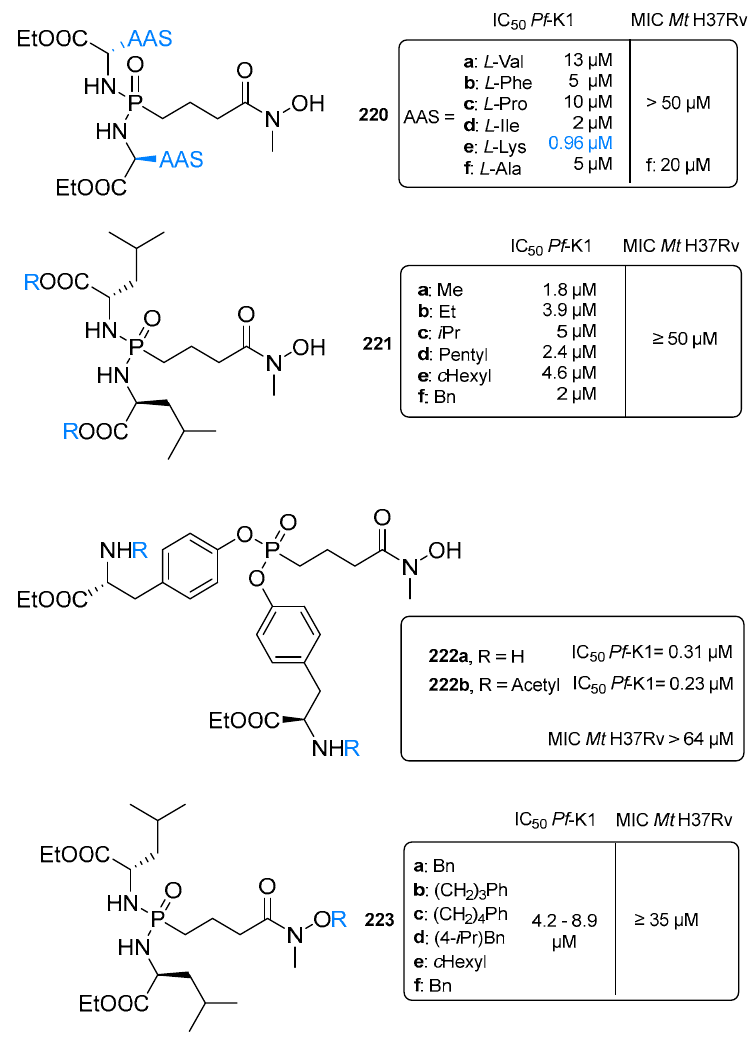
Figure 41 . Biological data of amino acid-based prodrugs 220a – f , 221a – f , 222a – b , and 223a – f against asexual blood stages of Pf -K1 (IC 50 in µ M) and Mt H37Rv (MIC in µ M). AAS = Amino acid side chain. The α -3,4-dichlorophenyl substitution of reverse fosmidomycin derivatives is a